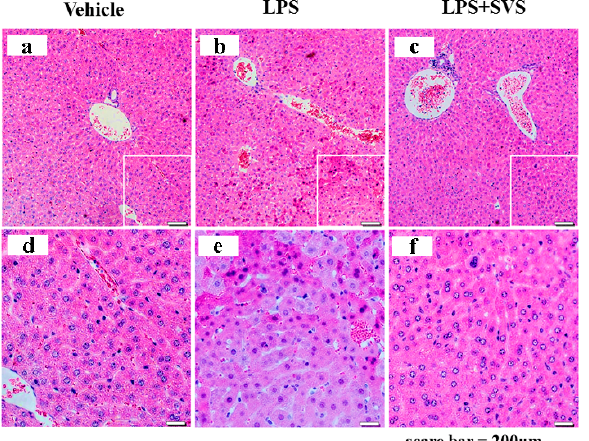
Figure 11. Histological sections of mouse livers. Scale bar represents 200 μ m. Panels d , e , and f are images amplified from panels a , b , and c , respectively.